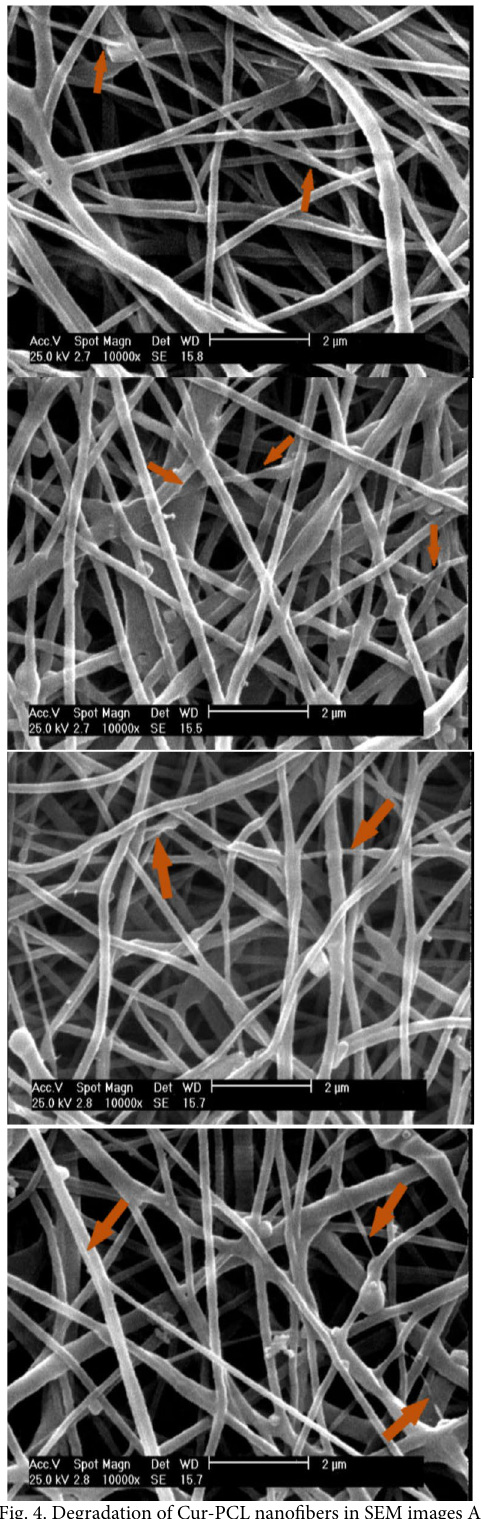
Fig. 6. Comparing total adhesion score of treatment (treated with Cur-PCL nanofibers after surgery) and control